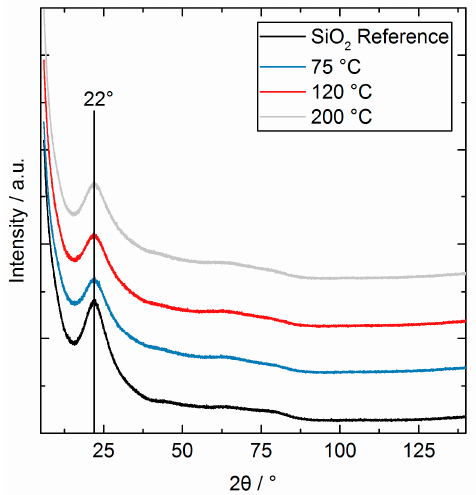
Figure 8. XRD pattern of the reference SiO 2 and the AlO x coated samples synthesized at different substrate temperatures after three cycles.